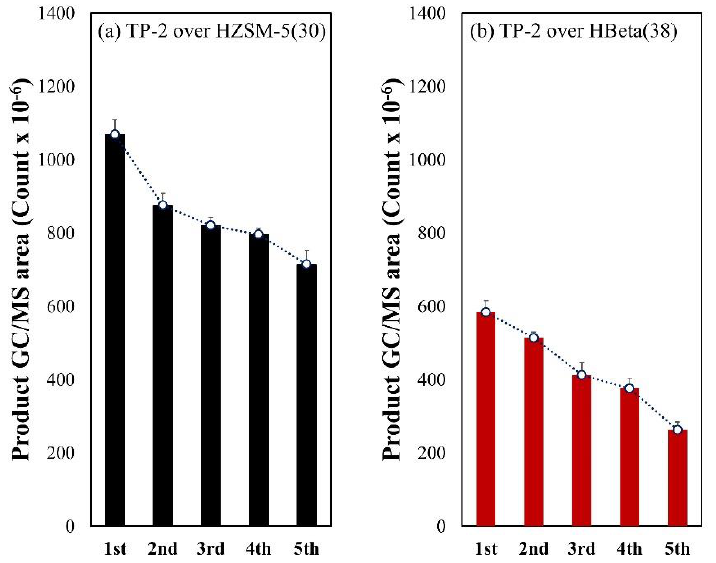
Figure 6. Comparison of GC/MS areas (count × 10 −6 ) for total aromatic hydrocarbons (TAHs) obtained from the five times sequential catalytic pyrolysis reactions of TP-2 over ( a ) HZSM-5(30) and ( b ) HBeta(38).